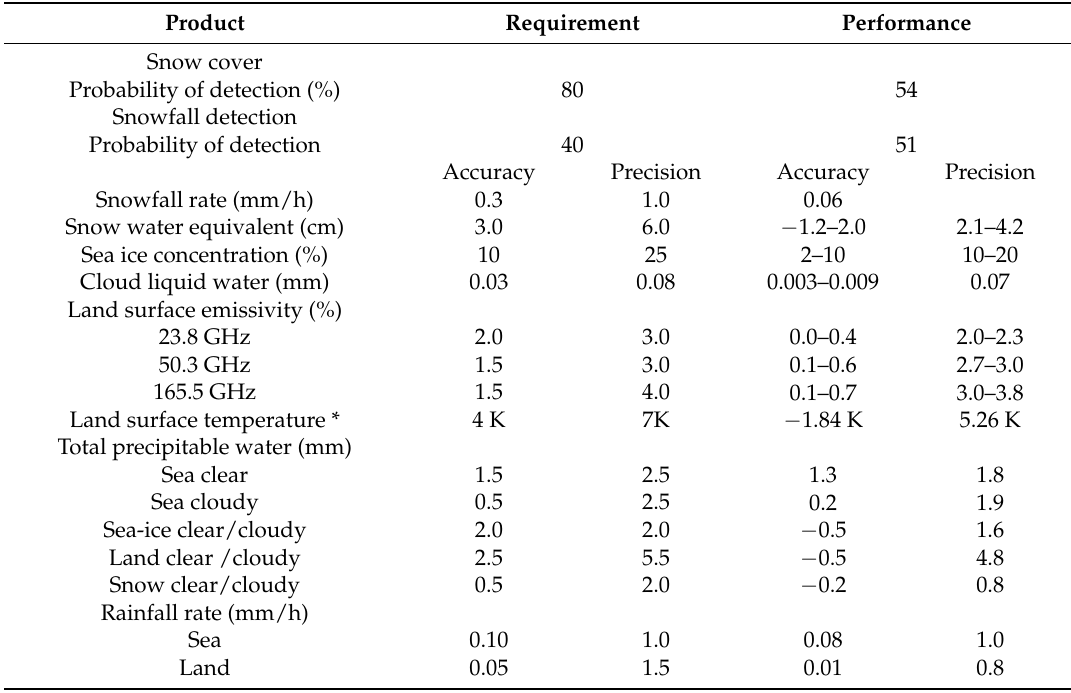
Table 13. S-NPP MiRS products